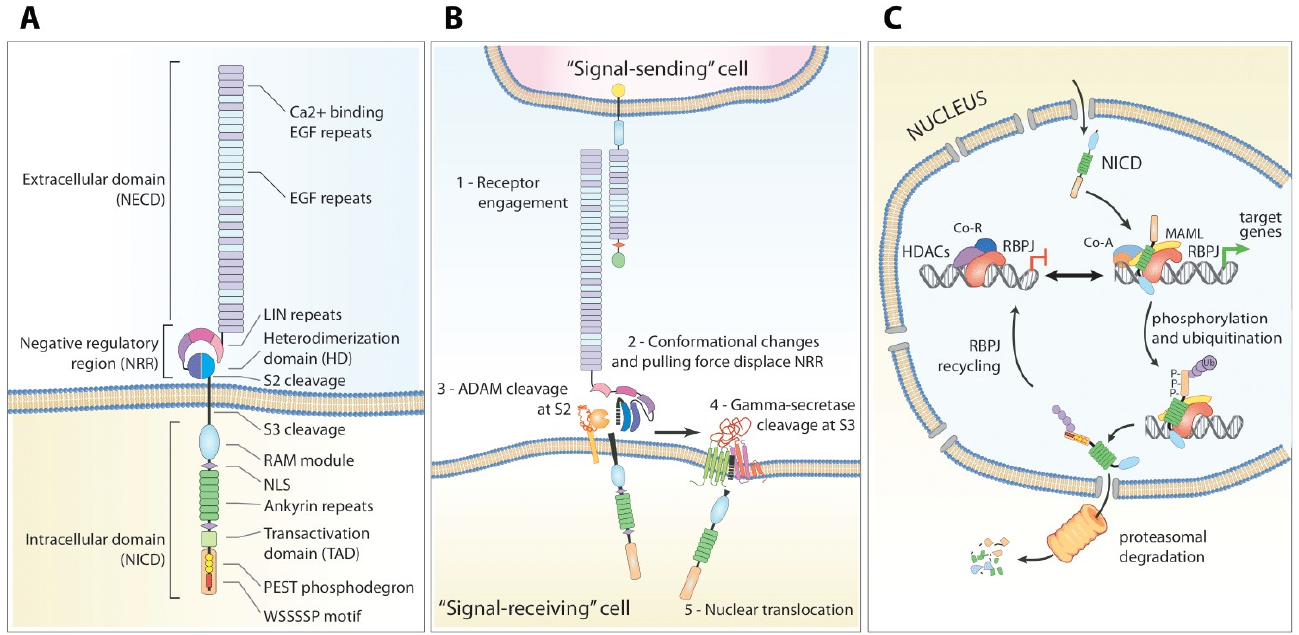
Figure 1. Structure and function of NOTCH1 signaling. ( A ) The NOTCH1 receptor consists of a single-pass transmembrane heterodimer organized in multiple functional domains, organized in three main regions: the extra-cellular domain (NECD), responsible for ligand binding; the negative regulatory region (NRR), which regulates receptor activation; the intra-cellular domain (NICD), which incorporates transcription effector functions. The NECD is essentially composed of 36 consecutive epidermal growth factor (EGF)-like domains responsible for ligand binding; the NRR is a beautifully simple but complex system of folded regions composed of three Lin12/Notch repeats (LNRs) that sterically protect the heterodimerization domain (HD). The NICD is composed by a protein-binding RBP-Jκ-associated molecule (RAM), seven ankyrin (ANK) repeats flanked by two nuclear localization signals, a transcriptional activation domain (TAD) and a glutamate, serine and threonine (PEST) domain. The PEST domain regulates NICD stability and degradation through multiple phosphosignals and the WSSSSP motif is recognized by E3 ubiquitin-ligases. ( B ) Mechanism of signal transduction. The ligand-engaged NECD is “pulled” toward the signal- sending cell (expressing the ligand) unfolding the three-dimensional protein structure of the NRR and exposing the HD. Nearby ADAM metalloproteases then cleave the NOTCH1 protein at the S2 site, whereas the gamma-secretase complex cleaves the S3 site. The liberated NICD is now free to translocate to the nucleus. ( C ) Nuclear functions and turnover of NICD. The translocated NICD binds with high affinity to the transcription factor RBP-Jκ; this displaces RBP-Jκ from other repressor proteins and histone deacetylases (HDACs), and favors binding of activating co-factors including Mastermind-like (MAML) and p300 which promote transcription. Within a few hours, the NICD is progressively phosphorylated and ubiquitinated, disengaged from RBP-Jκ, and destined for proteasomal degradation. RBP-Jκ is then bound by repressor proteins, shutting down the transcription program. On the cytoplasmic side of the membrane, the Notch intra-cellular domain (NICD) is composed of a protein-binding RBP-Jκ-associated molecule (RAM), seven ankyrin (ANK) repeats flanked by two nuclear localization signals, a transcriptional activation domain (TAD), and a C-terminal region rich in proline, glutamate, serine and threonine (PEST). The PEST domain acts as a phosphodegron domain, as it contains multiple phosphosignals (reviewed in [55]) and motifs for substrate recognition by E3 ubiquitin- ligases that allow for fine-tuned regulation of protein stability and degradation [29,56,57]. Although very similar in structure, amino-acid composition and slight structural variations differentiate NOTCH2-3-4 from NOTCH1 (reviewed in [34] for B-cell malignancies), including the number of EGF repeats and the presence of TAD modules in the cytoplasmic domain, dramatically changing the function of each receptor.